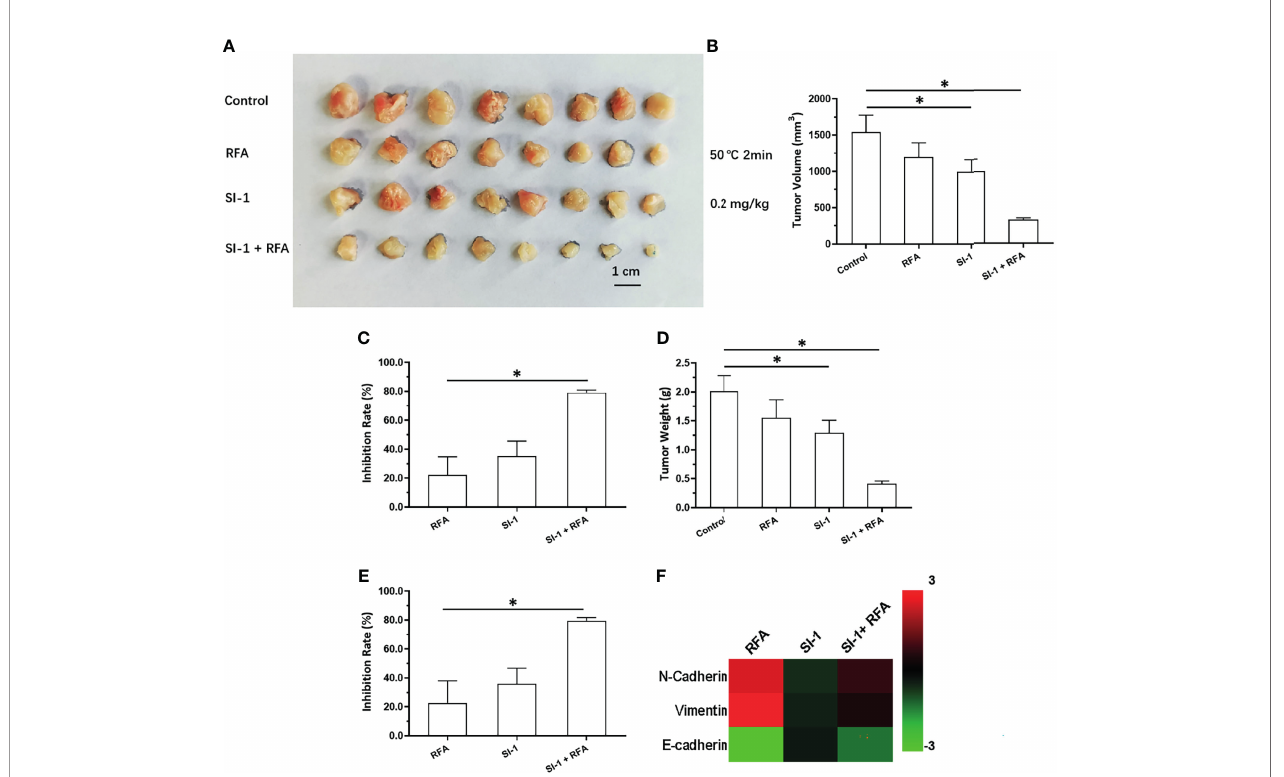
FIGURE 5 | The in vivo antitumor activation of SI-1 with RFA on MHCC97-H cells. The MHCC97-H cells were cultured and injected into the subcutaneous position to form the subcutaneous tumor tissues. Then, the mice were received the RFA (50°C for 2min) or SI-1 (0.2 mg/kg) or RFA + SI-1. The results were shown as images of tumors (A) , the tumor volumes (B) , the inhibitory rates according to the tumor volumes (C) , the tumor weights (D) , the inhibitory rates according to the tumor weights (E) , and the heat-map (F) . *P < 0.05.